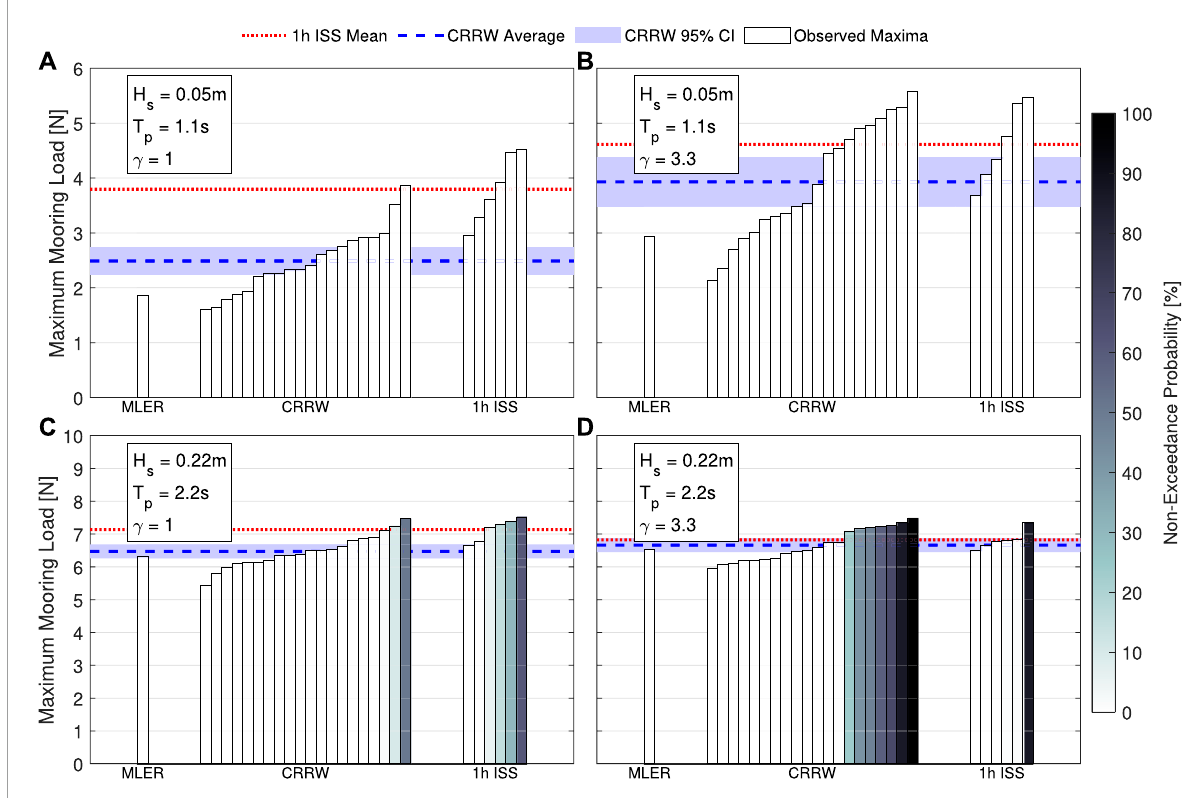
FIGURE 11 Maximum mooring load response obtained from the single and constrained SDWs, and irregular sea states. The average maximum response from each of the CRRW runs is also presented (blue dashed lines), along with the 95% confidence interval (shaded region), and average maxima from the 1 h irregular sea state. Each bar is coloured based on the non-exceedance probability. Each subplot (A–D) is a different sea states (parameters shown in the top